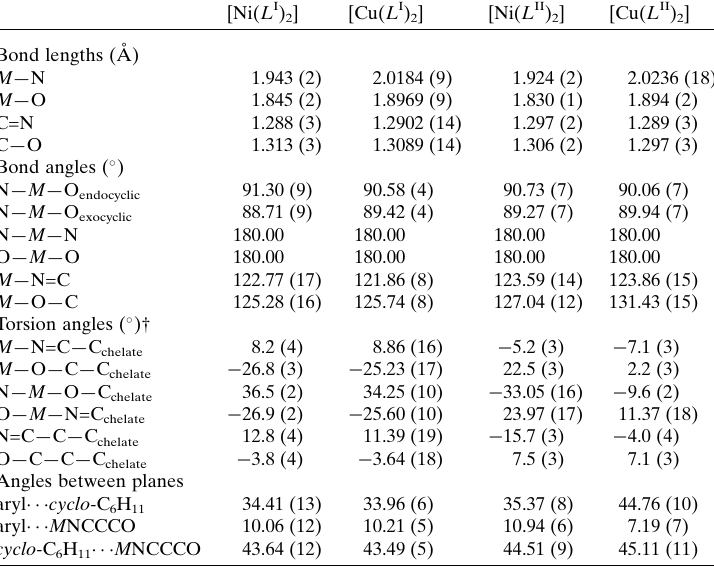
Table 1 Selected bond lengths (A˚ ) and angles ( (cid:5) ) for [Ni( L I,II ) 2 ] and [Cu( L I,II ) 2